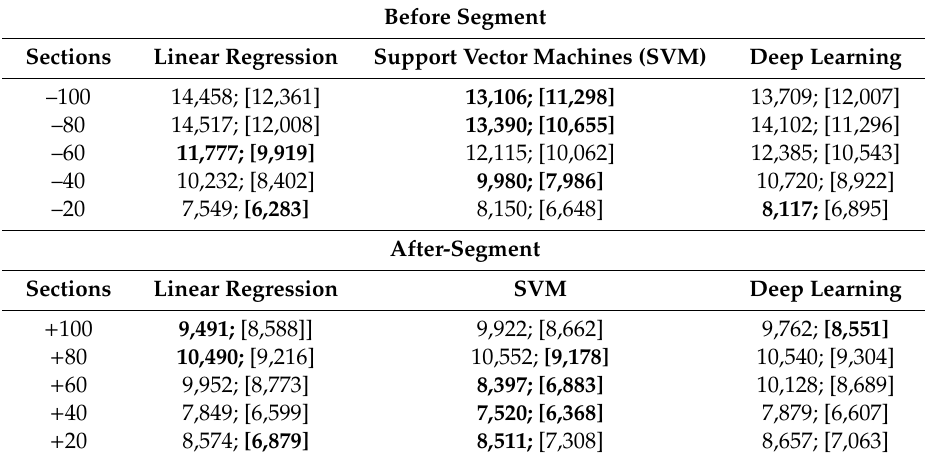
Table 2. Comparison of the Root Mean Squared Error ( RMSE ) and Absolute Error ( AE ) metrics for vehicle speed estimation.